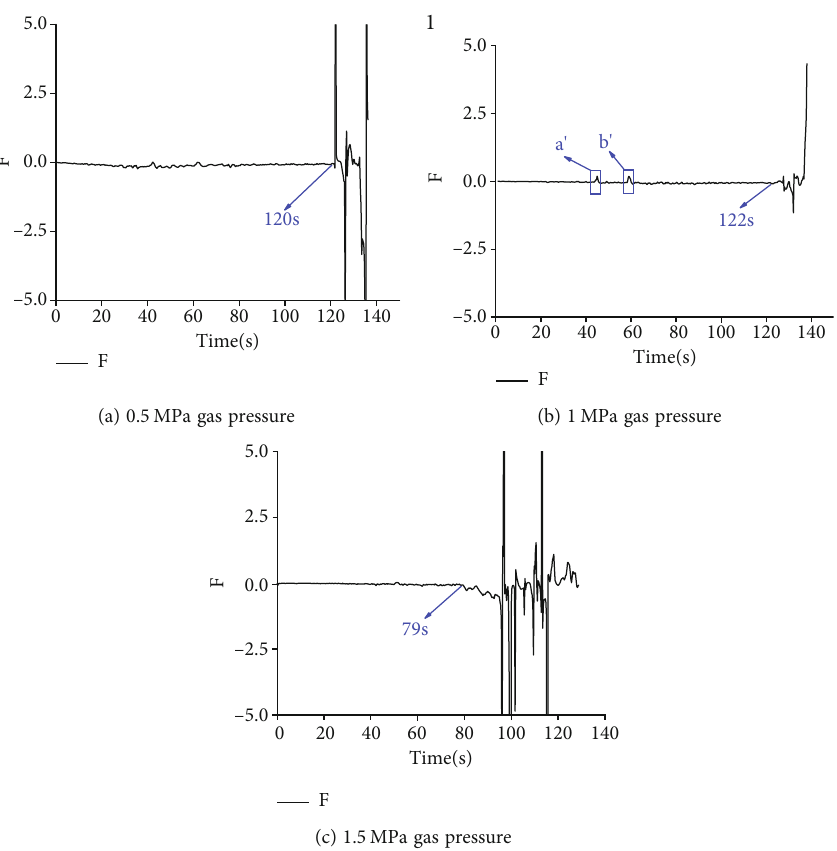
Figure 15: The variation curve of the F value under di ff erent gas